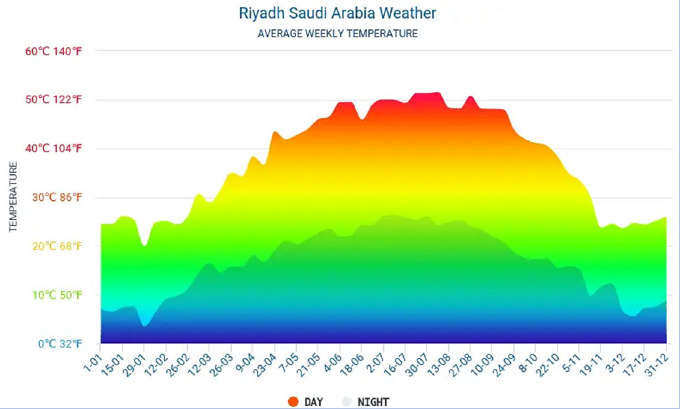
Figure 4. Average weekly temperature for Riyadh, Saudi Arabia from 2015–2022 [29]. Table 1. Average monthly temperature for Riyadh, Saudi Arabia from 2015–2022 [29].